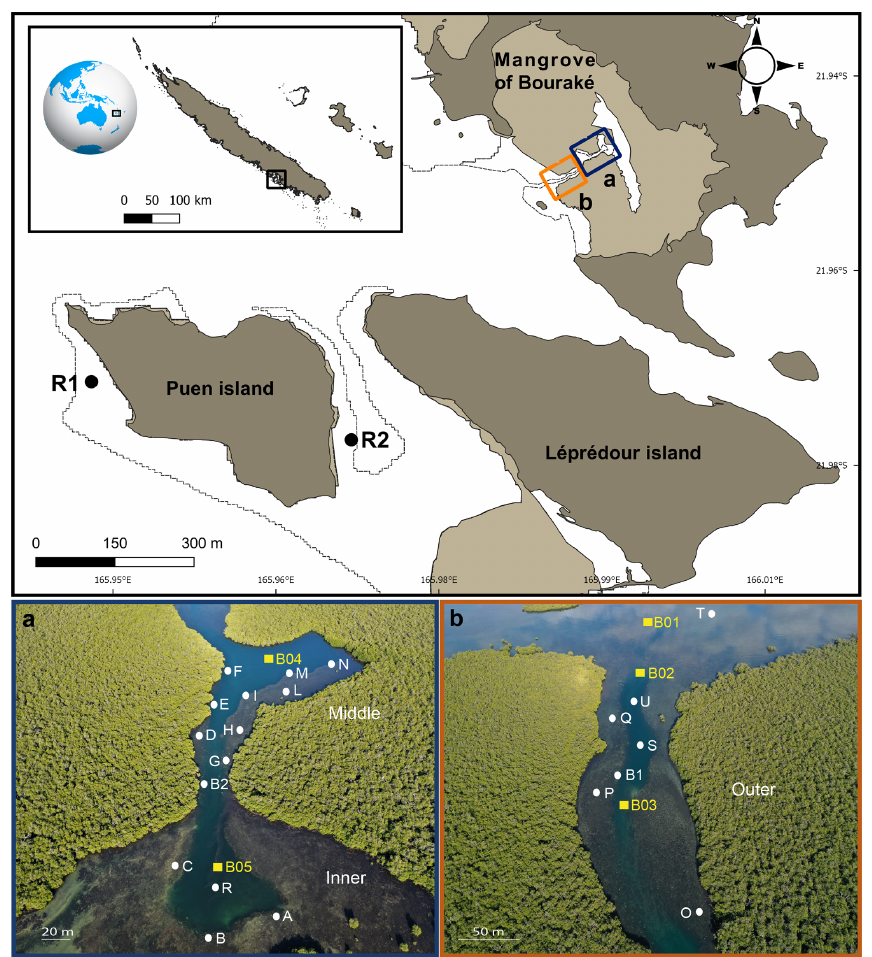
Figure 1. Map of the study site (top panel) showing the semi-enclosed mangrove lagoon of Bouraké and reference reefs (R1 and R2). Photos (a) and (b) are aerial pictures (taken at 130m above the Bouraké lagoon) of the inner (bottom) and middle reefs (a) and the outer reef (b) . White dots and yellow squares indicate the sampling stations used for physical and chemical environmental monitoring, respectively. Georep New Caledonian database (https://georep.nc/, last access: January 2021) and QGis software were used to build the figure (top